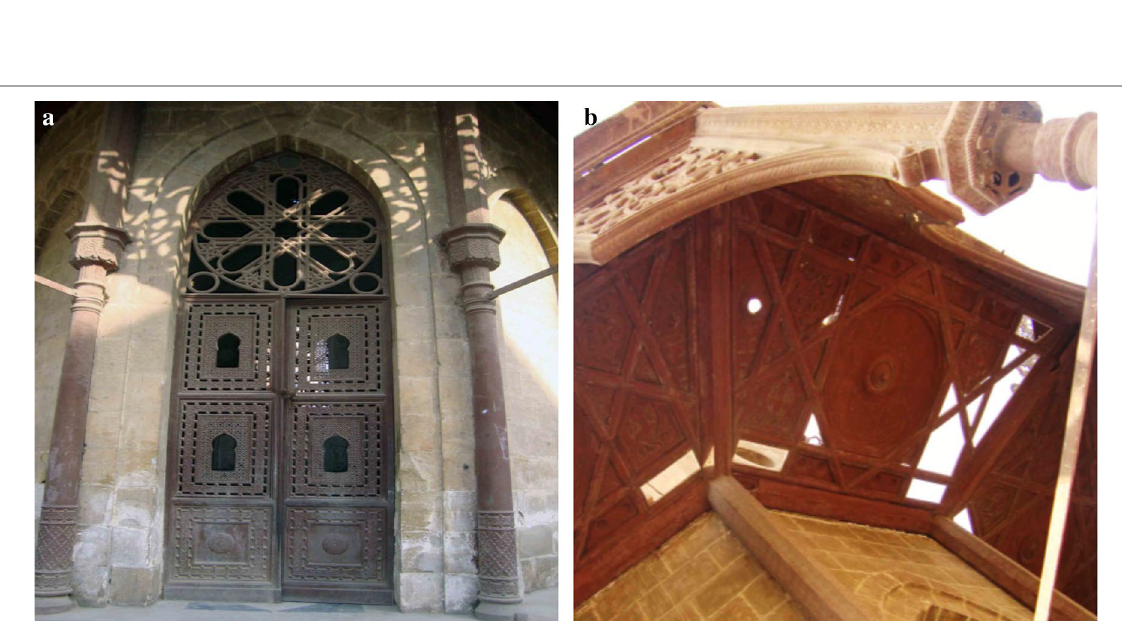
X‑ray diffraction